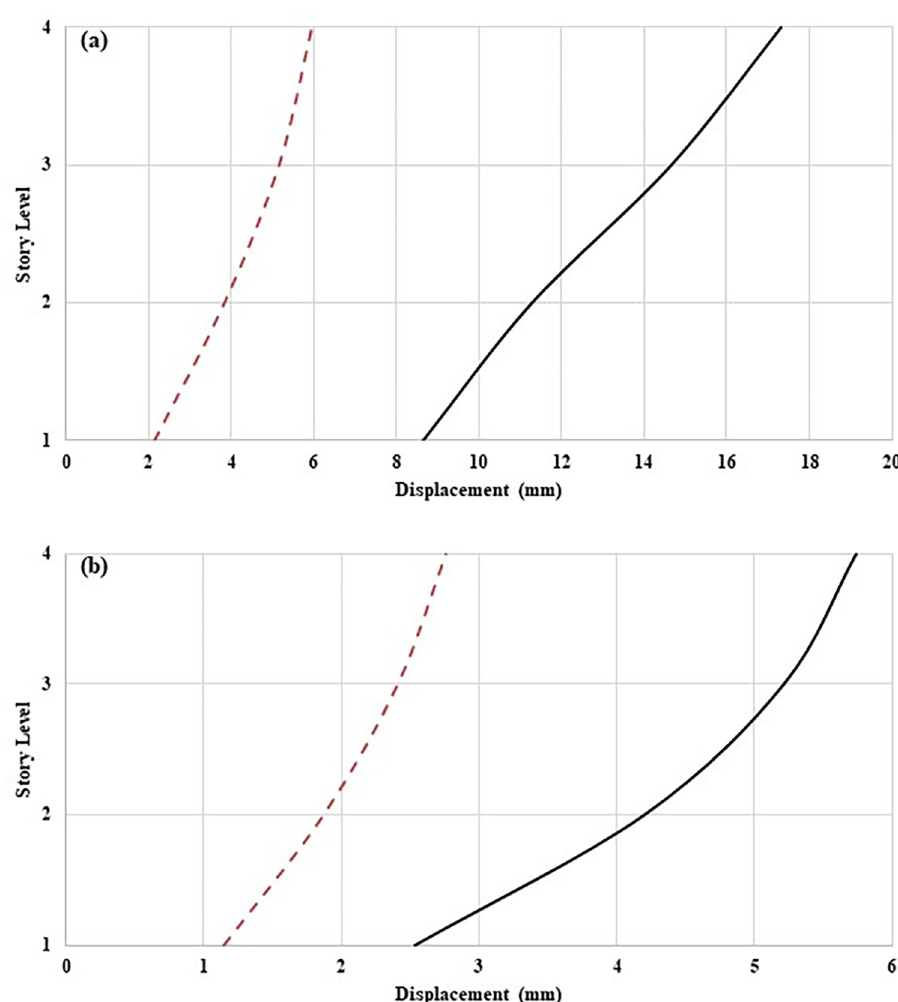
Fig 9. RMS displacement responses of MDOF structure equipped with and without TLCD at (a) Resonant loading, and (b) Seismic